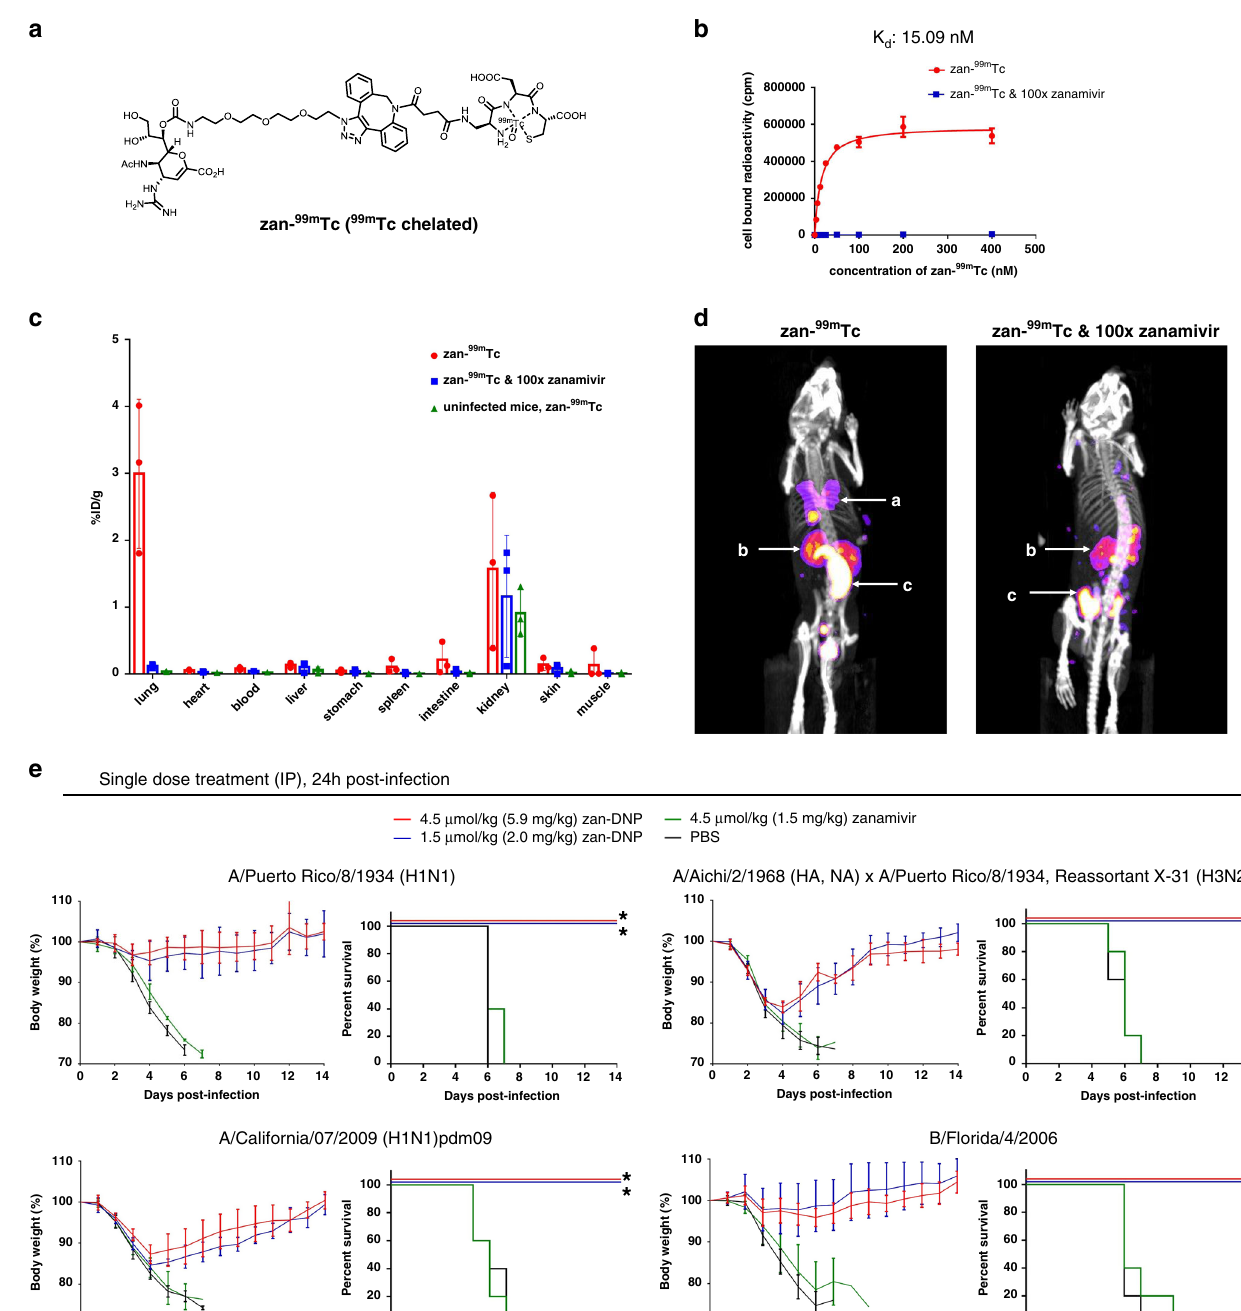
Fig. 5 Examination of the properties of parenteral administration of zan-DNP. a Structure of zanamivir- 99m Tc conjugate (zan- 99m Tc). b Binding of zanamivir- 99m Tc to N1 neuraminidase (expressed on A/Puerto Rico/8/1934 (H1N1) virus-infected MDCK cells) in the absence (red curve) and presence (blue curve) of 100-fold excess zanamivir (competitor) ( n = 3). c Biodistribution of intravenously injected (IV) zan- 99m Tc in A/Puerto Rico/8/1934 (H1N1) virus-infected mice (3 mice/group). d SPECT/CT images showing the locations of intravenously injected zan- 99m Tc in A/Puerto Rico/8/1934 (H1N1) virus-infected mice (left panel) or virus-infected mice which concurrently received 100-fold excess free zanamivir (right panel) (3 mice/group). a: lung; b: kidney; c: bowels. e Weight loss and survival curves of virus-infected mice treated with zan-DNP or zanamivir. DNP-KLH immunized BALB/c mice (5 mice/group) were challenged with 100x MLD 50 of the in fl uenza virus strains indicated above each panel. Mice were treated with a single dose of zan- DNP by intraperitoneal administration (IP) 24 h post-infection. Mice were counted as dead when they lost either 25% of their initial weight or became moribund. Statistical differences between PBS and drug treatment groups were determined by two-sided log-rank test (* P < 0.005, see exact P values in Supplementary Table 1). Data are presented as mean values±